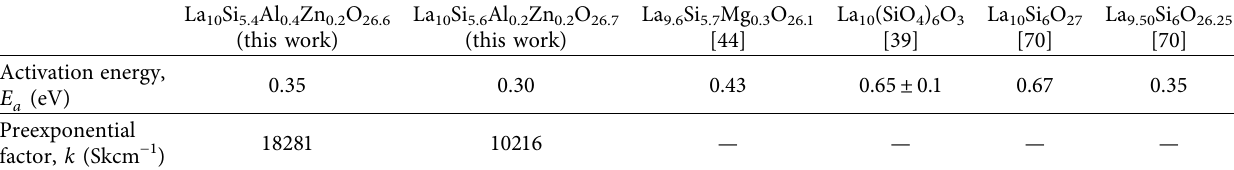
Table 3: Comparison of activation energy E a and preexponential factor k of La 10 Si 6 − x − 0.2 Al x Zn 0.2 O 27 − δ ( x